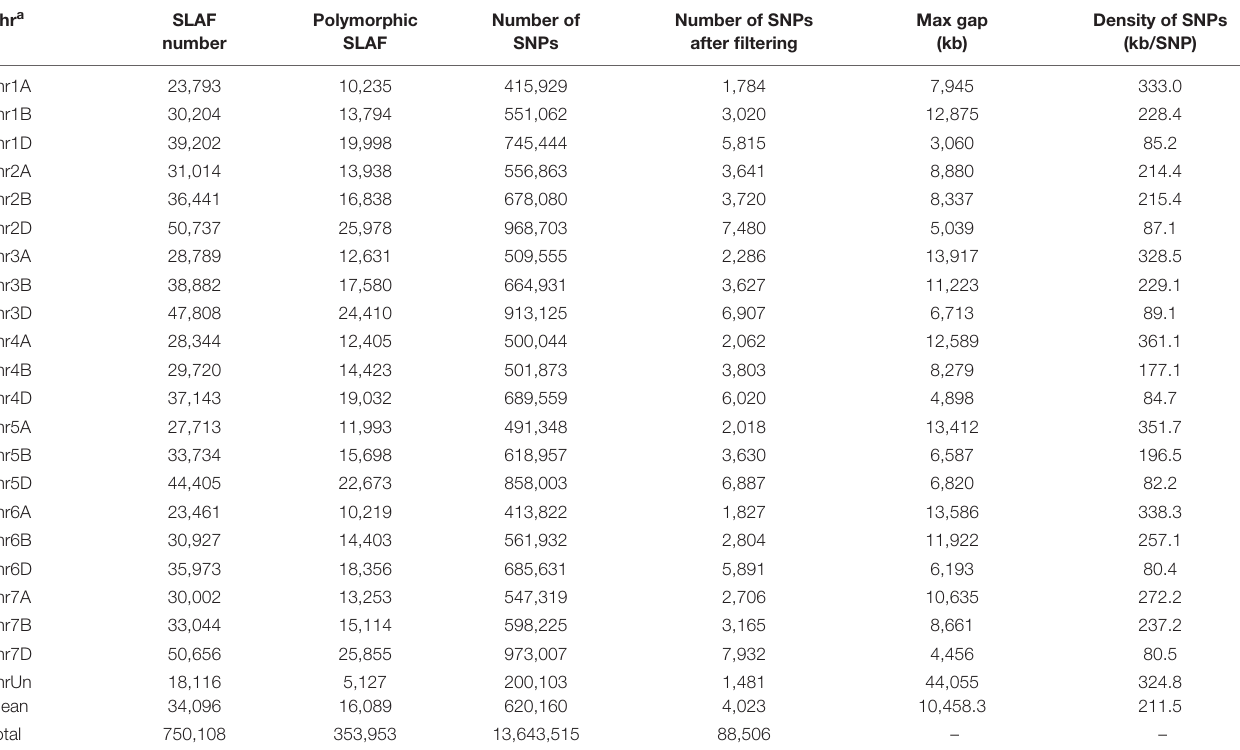
TABLE 1 | Distribution and summary of E. sibiricus genome-wide